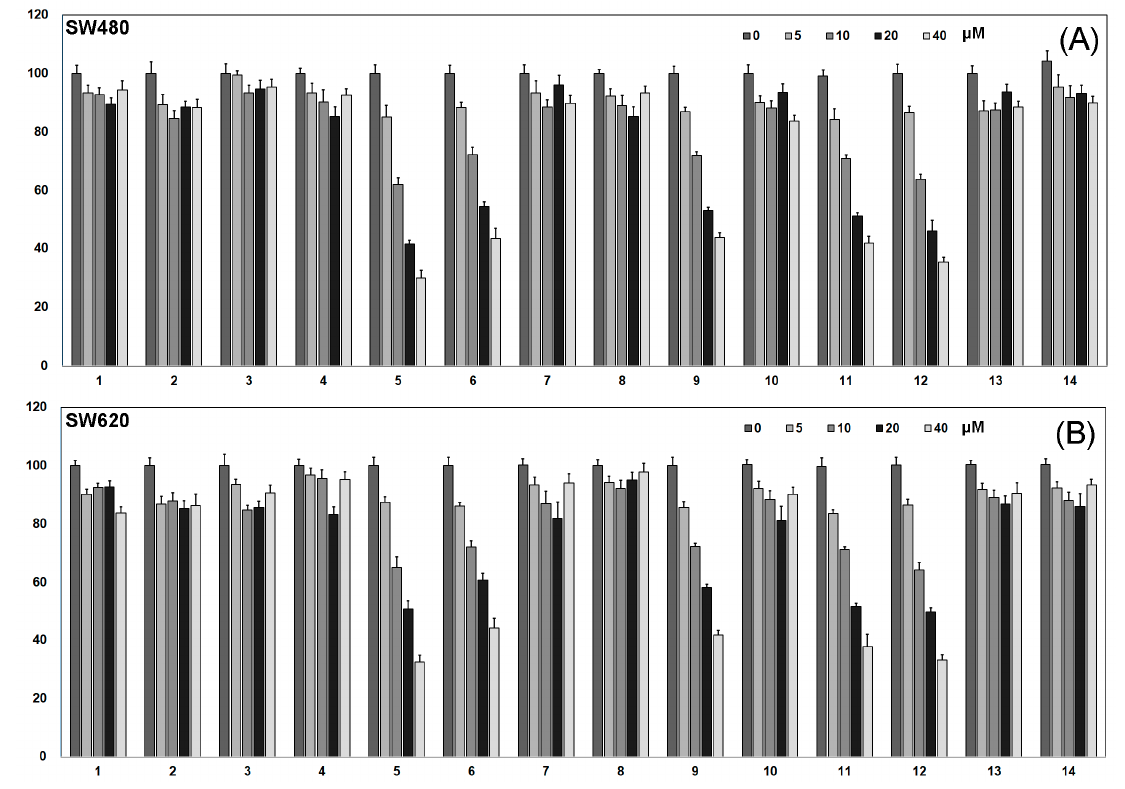
Figure 3. Cell viability as determined by CCK8 assay. ( A ) Compounds 1 – 14 inhibit SW480 cell viability; ( B ) Compounds 1 – 14 inhibit SW620 cell